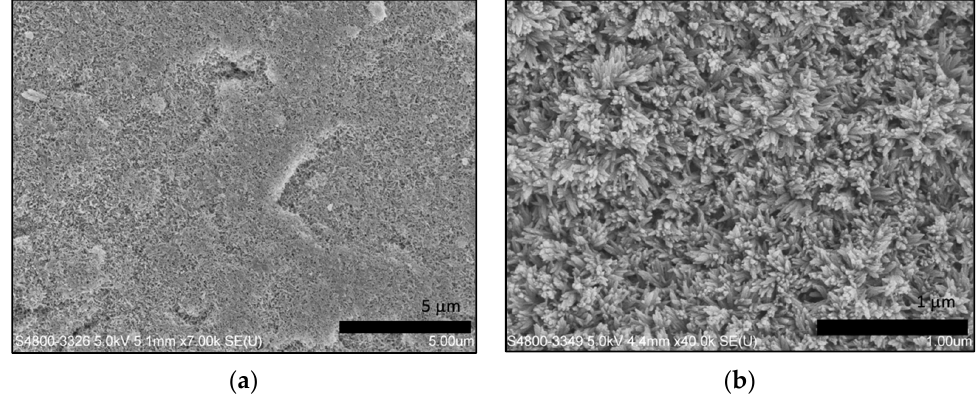
Figure 5. SEM micrograph of remineralized dentin surface in the experimental group with addition of GO: ( a ) with 7.00 k × magnification; ( b ) with 40.0 k × magnification.